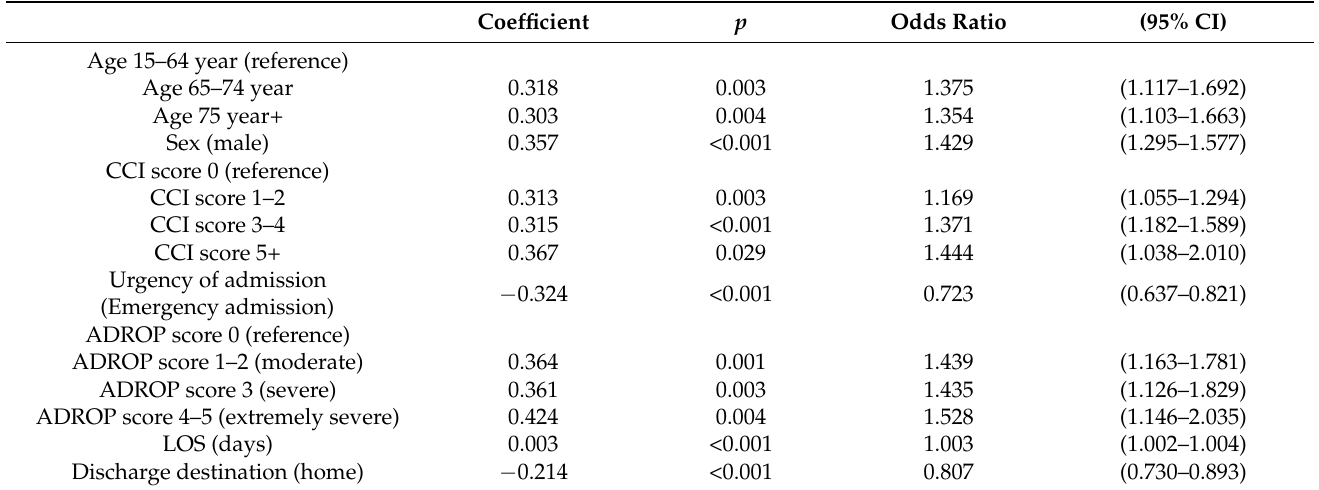
Table 2. Variables for the logistic regression analysis using the 9-year